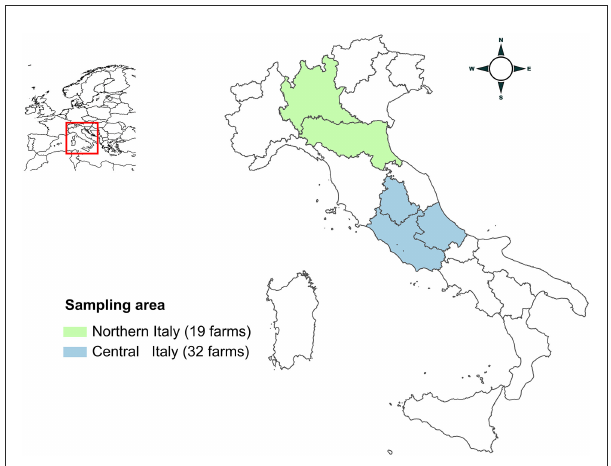
FIGURE1 Map of Italy showing the areas of sampling. Lombardia and Emilia-Romagna regions (Northern Italy) are highlighted in green; Lazio, Umbria and Abruzzo regions (Central Italy) are highlighted in